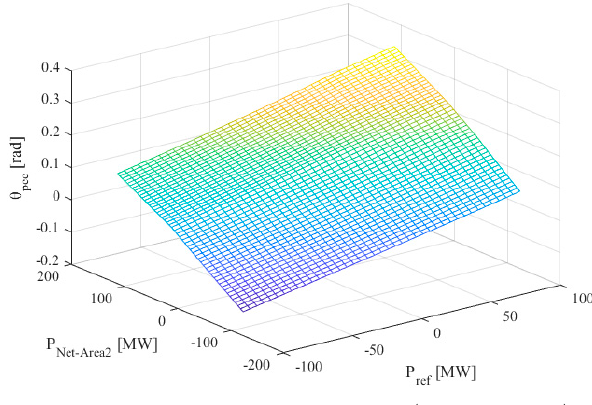
Figure 15. Response curve of 𝜽 𝑷𝑪𝑪 = 𝒇(cid:3435)𝑷 𝒏𝒆𝒕(cid:2879)𝑨𝒓𝒆𝒂𝟐 ,𝑷 𝒓𝒆𝒇 (cid:3439) .